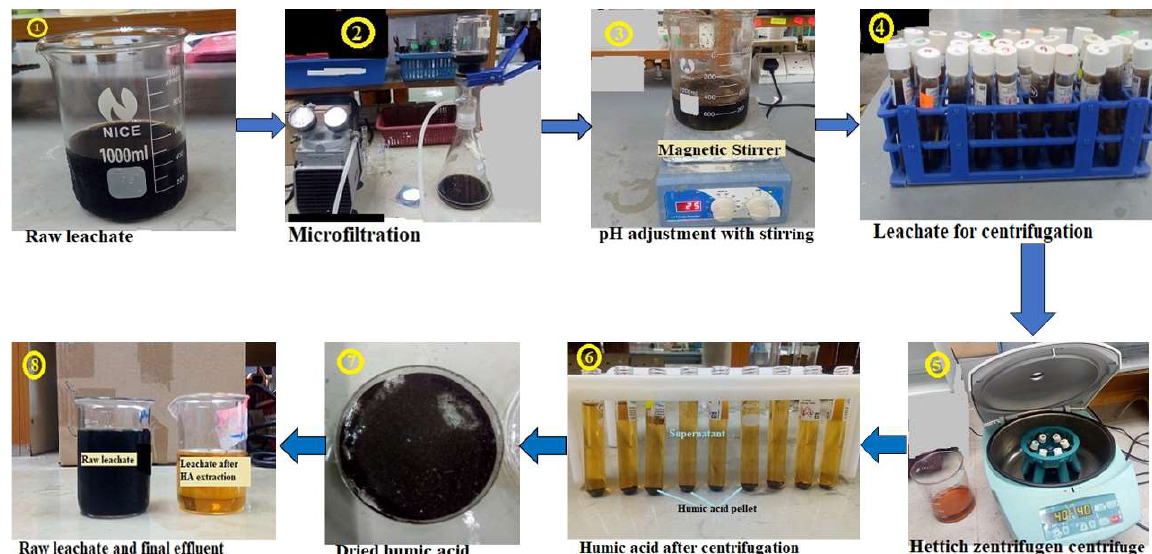
Figure 3. Humic acid isolation from stabilized leachate HSs fraction.